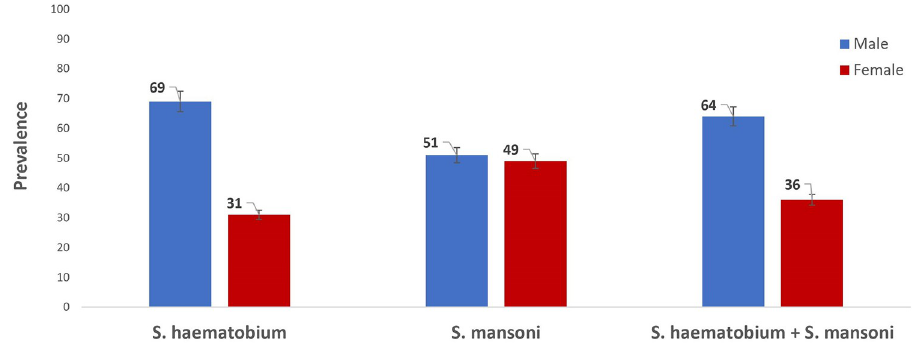
Fig 3. Prevalence of schistosomiasis by sex among the study participants. Source: The authors using their primary data to create this chart in Microsoft Excel software. Permission: The authors give permission to re-use this map.